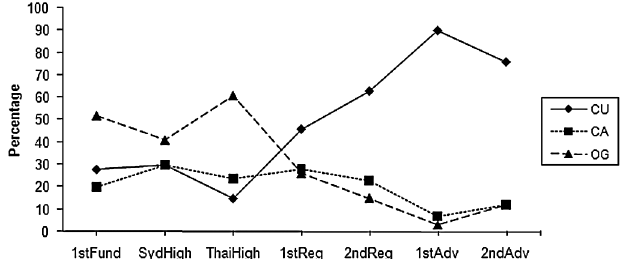
FIG. 2. The percentages of students’ responses obtained using the categorizing and counting technique are plotted against previous engagement with physics learning (ranked as in Table II) for questions 4 and 5 on the speed of waves on